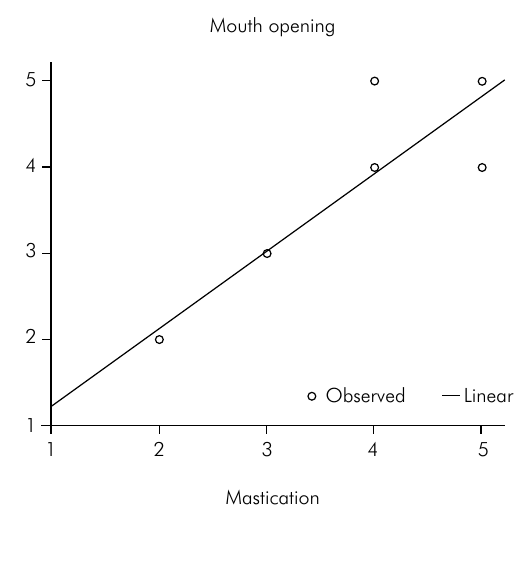
Figure 4. Correlation between Likert scale values associated to mouth opening and mastication (linear regression